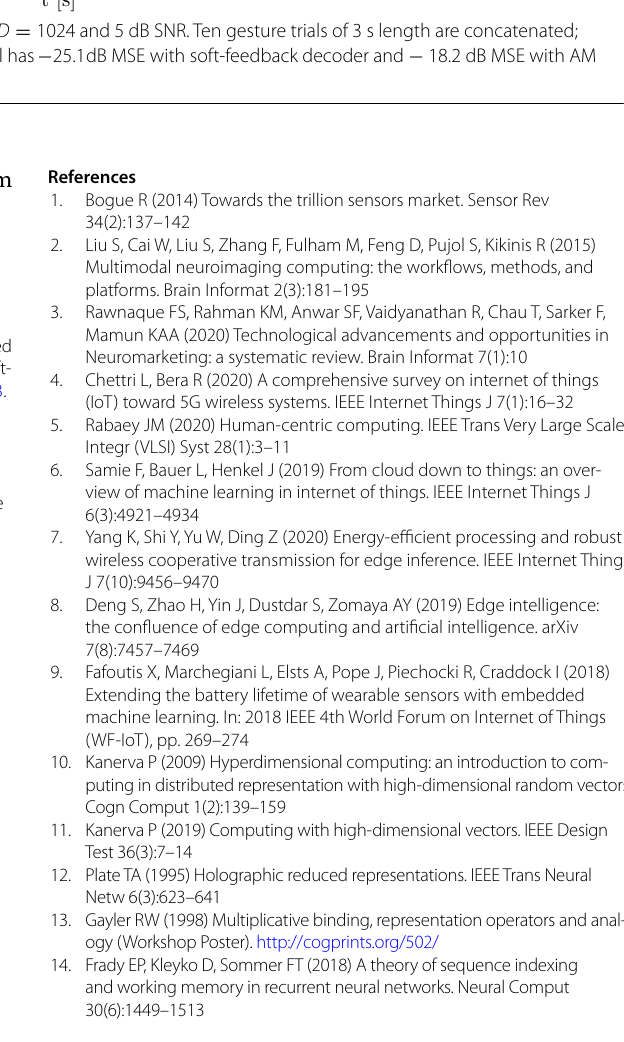
18.2 dB MSE with AM −